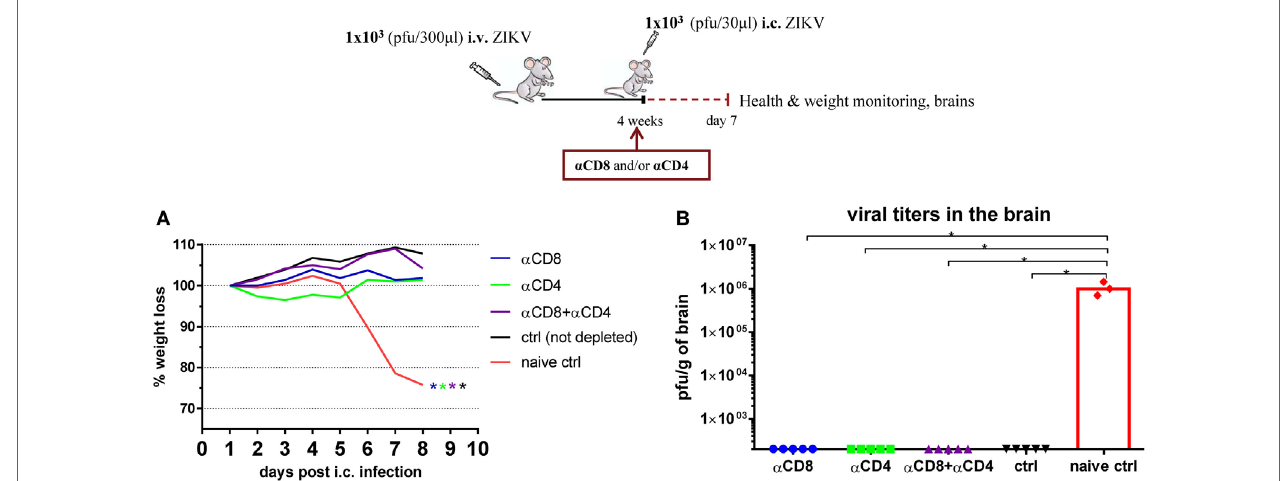
FigUre 11 | In vivo depletion of T cells. Wild-type C57BL/6 mice were inoculated with 1 × 10 3 pfu Zika virus (ZIKV) i.v. and mice were challenged with 1 × 10 3 pfu ZIKV i.c. On day − 1, 1, and 4 post i.c., mice were depleted of CD8 ( α CD8) and/or CD4 ( α CD4) T cells. Mice were weighed and monitored daily (a) , and on day 7 post i.c. challenge, brains were removed and viral titers were measured by a plaque assay (B) . Groups of undepleted immunized and naïve mice were used as positive and negative controls, respectively. The detection limit for virus was determined as 250 pfu/g of brain. Each dot represents an individual animal and bars the medians of the groups. The weight curves depict the group medians. n = 3–5 mice/group, * p < 0.05. Immunized and naïve mice of the same strain is compared; the color of the star denotes the treated group used for statistical comparison. The results of one of two identical experiments are depicted.